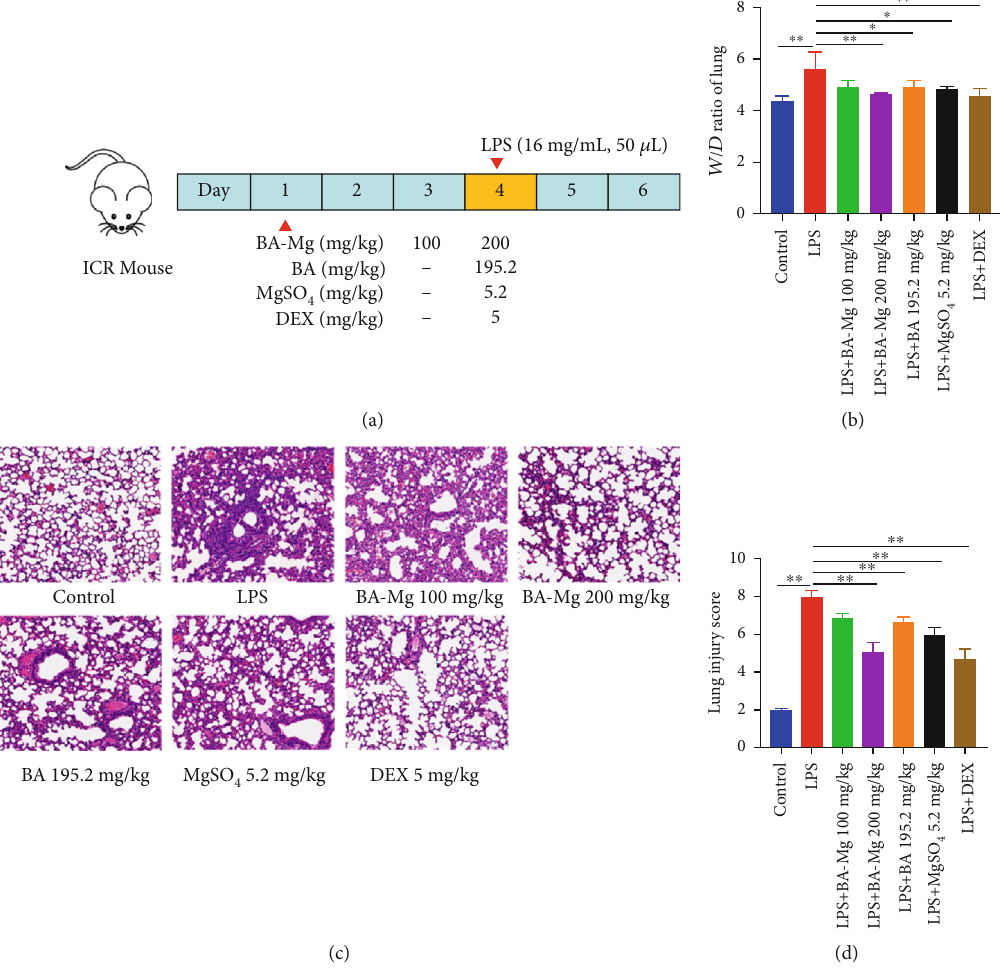
Figure 2: BA-Mg alleviated LPS-induced ALI in mice. (a) Experiment design. Mice were injected intraperitoneally BA-Mg, BA, and MgSO for 3 days before nasal instillation of LPS, and samples were collected at 48 h after LPS stimulation. (b) Lung W / D ratio. (c) Representative H&E staining of lung tissue sections. (d) Histological score. LPS: lipopolysaccharide; BA-Mg: baicalin-Mg; BA: baicalin; DEX: dexamethasone. Data were represented as mean ± SD ( n = 5 ). ∗ P < 0 : 05 , ∗∗ P < 0 : 01 versus LPS